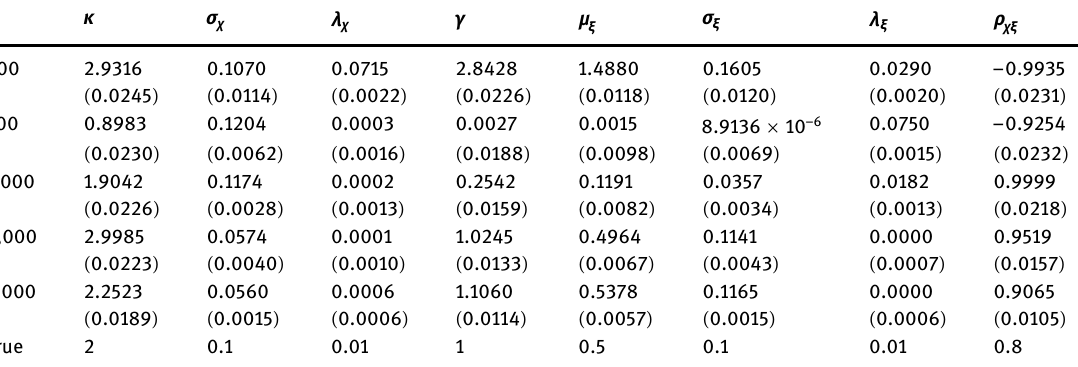
Table 1: Estimates of parameters indicated in top row. Their true values are given in the last row. n is used for number of time - steps indicated; ( standard errors are provided and were computed using 1,000 paths